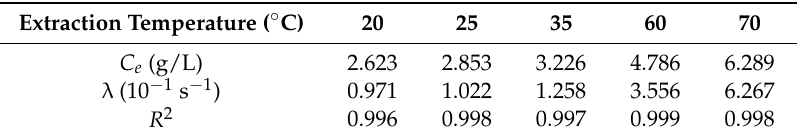
Figure 8. The relationship of ln ( C e − C t ) against extraction time ( t ) under different extraction temperatures. Table 3. Parameters of kinetic model of glycyrrhizic acid from Glycyrrhiza uralensis with different extraction temperatures.